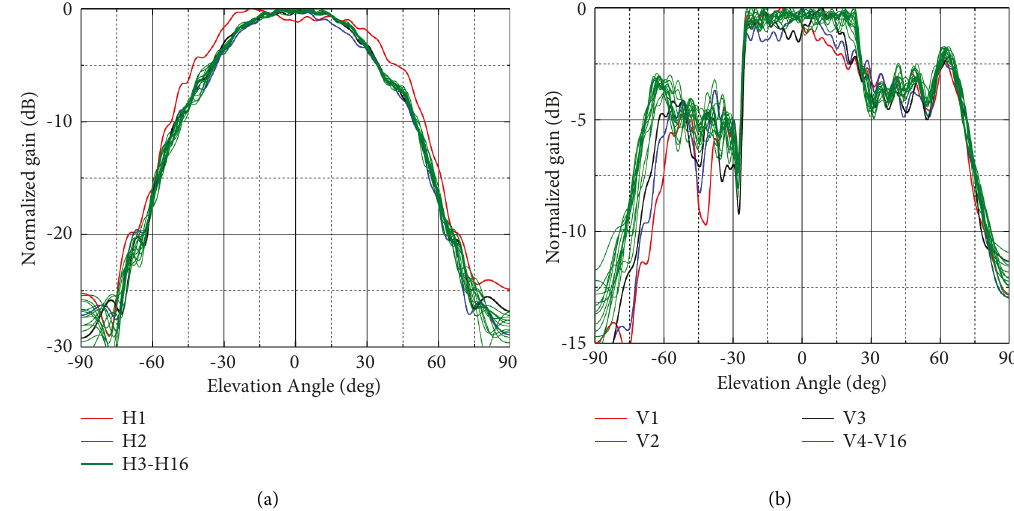
Figure 5: (a) Elevation pattern of H-polarization waveguide slot antenna. (b) Elevation pattern of V-polarization waveguide slot